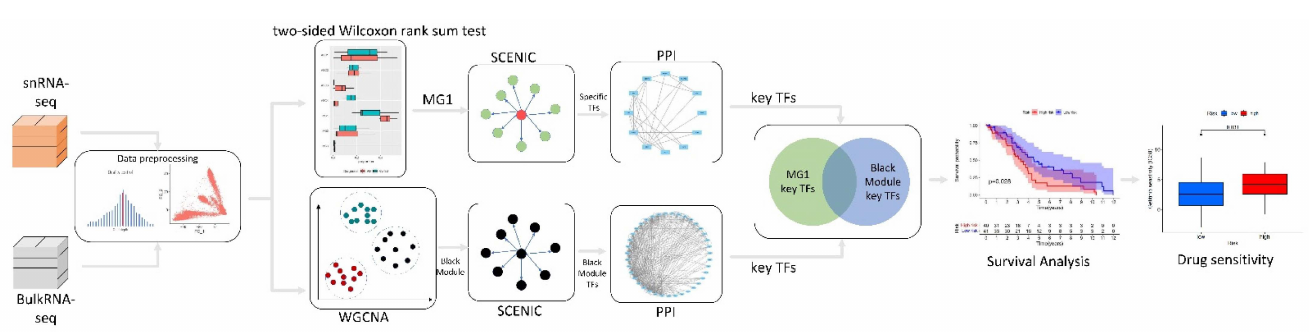
Figure 1. Framework of the